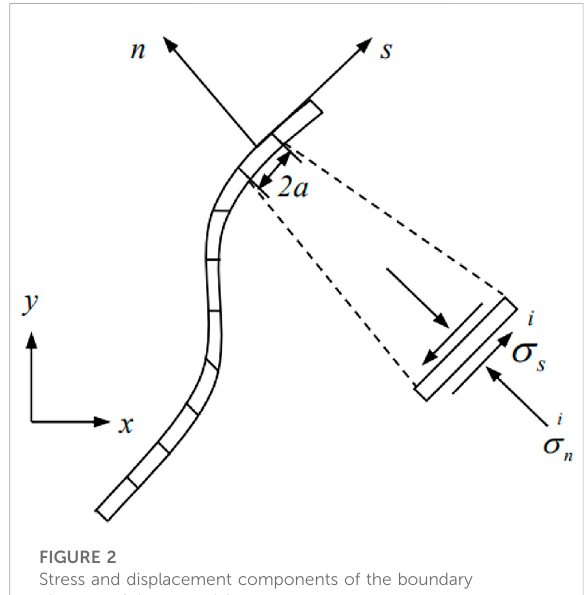
FIGURE 2 Stress and displacement components of the boundary element of the curved fracture